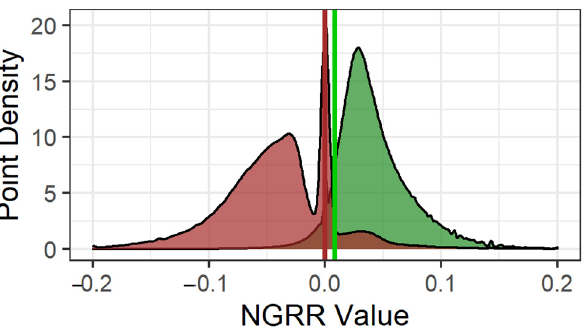
Figure 2. Example density plot of Canopy (green) and Stem (red) NGRR values sampled from SfM point clouds at the MEF1 study area, with overlapping distribution segments are brown. Red and green vertical lines represent the 90th and 10th percentile of the Stem and Canopy NGRR values, respectively.